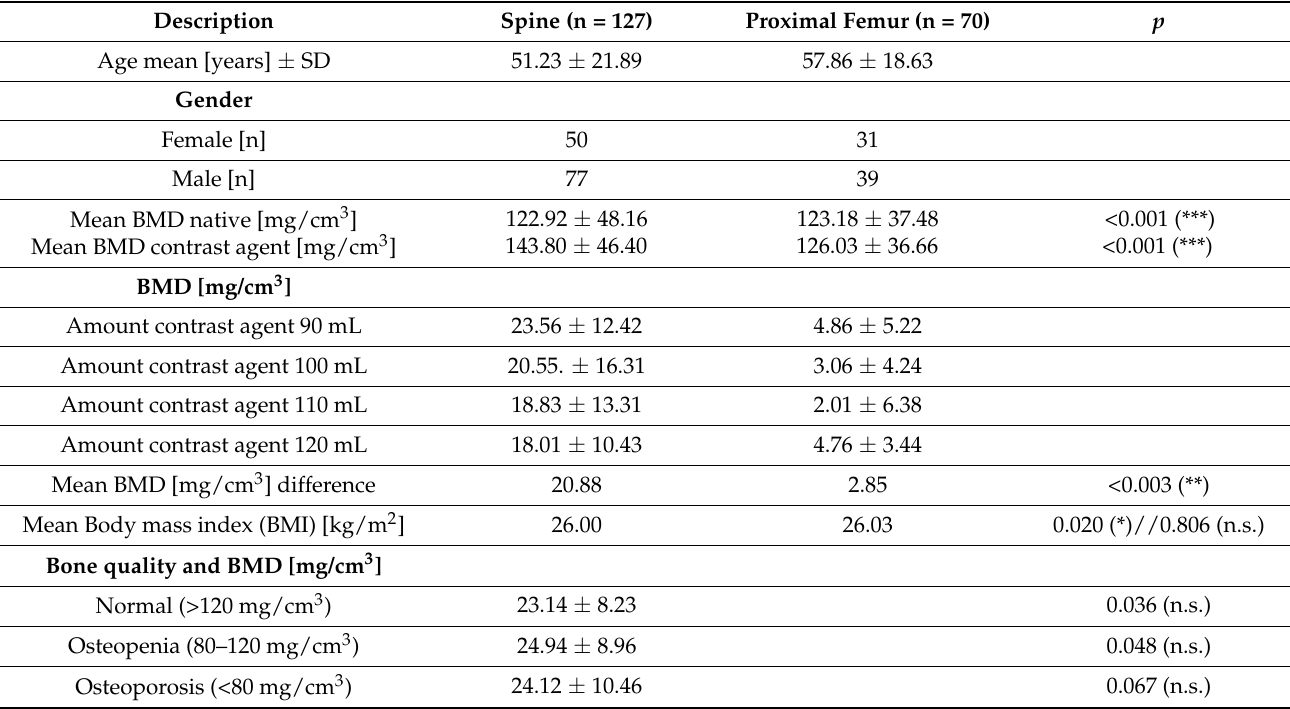
Figure 3. Bland – Altman plot for comparison of bone mineral density (BMD) with and without contrast agent administration. Distribution of BMD of ( a ) spine patient cohort (n = 127) and ( b ) proximal femur patients (n = 70); red line shows the mean value, dashed green lines show the standard deviation (+1.96 and − 1.96) and dots represent the distribution of data sets.